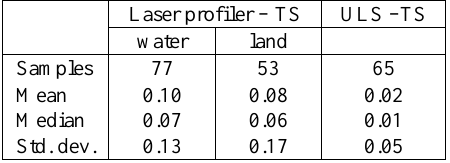
Table 1. Height differences [m] of laser profiler and ULS compared to check points from terrestrial survey